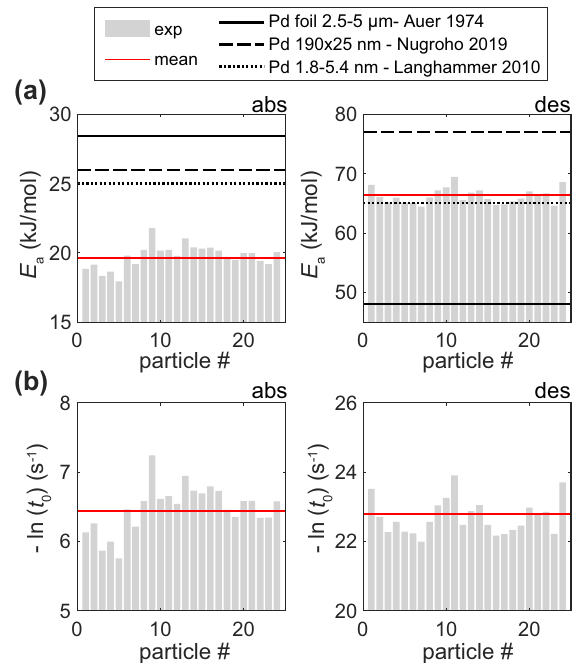
Fig. 2 Arrhenius parameters of individual Pd particles. a Apparent activation energy and b pre-exponential factor for absorption (left) and desorption (right) extracted for the 24 individual Pd particles. The light gray bars are data from LLS fi ts, with the mean value indicated as red solid lines. The data were extracted from a fi rst set of measurements, starting with the pristine as-grown sample, as shown in Supplementary Fig. 4, and included a full set of consecutive measurements across the T -range of 338 to 303 K. Black lines in the upper panel denote E a values for annealed Pd nanoparticles 39 of 1.8 – 5.4 nm in size (dotted), annealed Pd disks 38 of 190 nm in diameter and 25 nm in height (dashed) and Pd foil 37 of 2.5 – 5 µ m in thickness (solid). Analogous fi gure with NLLS data can be found in Supplementary Fig. 9. Goodness-of- fi t statistics for both methods are given in Supplementary Fig. 10 and the corresponding Arrhenius plots and nonlinear fi ts to the raw data in Supplementary Figs. 5 and